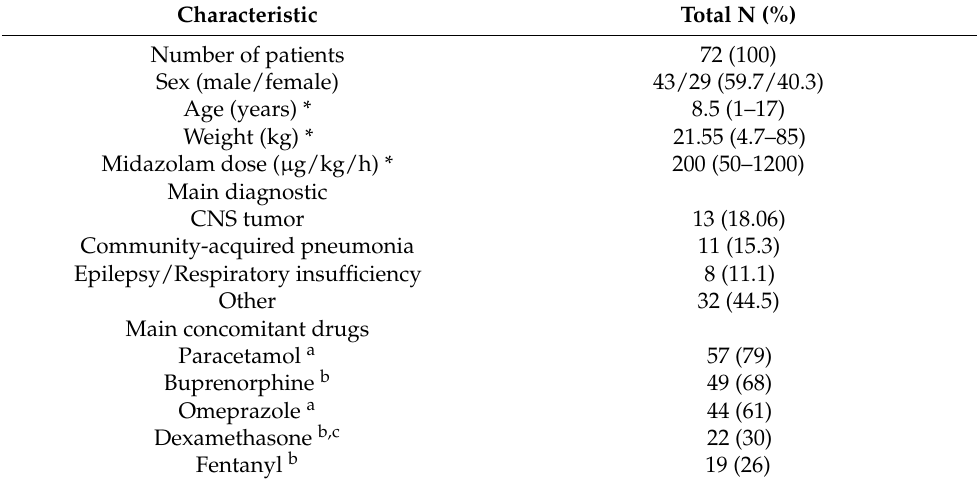
Table 1. Demographic and clinical